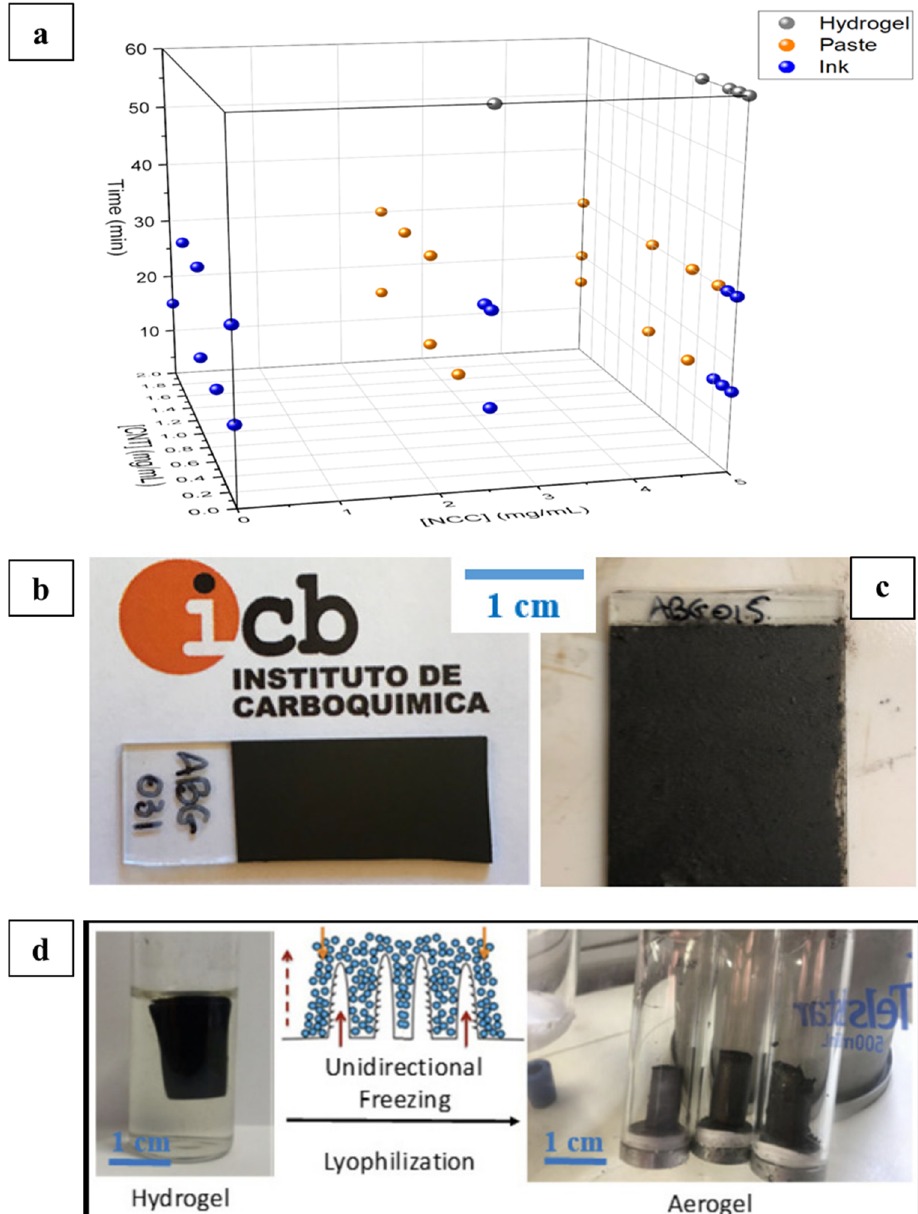
Figure 15. Three-dimensional scatter plot describing the effect of CNTs added in basic pH and conditions to obtain liquid inks (blue), viscous pastes (orange), and self-standing hydrogels (gray) ( a ). All samples had basic pH. Photographs of films made from low-viscosity inks ( b ) and high-viscosity pastes ( c ) on glass substrates. Real images of a hydrogel derived from hydrothermal treatment in water ( left ) and preparation scheme of aerogels by unidirectional freezing followed by lyophilization ( right ) ( d ), used with permission from ref. [70]. Table 1 summarizes examples of 3D printable nanocellulose composites, their sources, formulation, printing method and applications reported in literature. Table 1. Examples of 3D-printed nanocellulose composites, treatment, and formulation conditions for applications. Nanocellulose Treatment